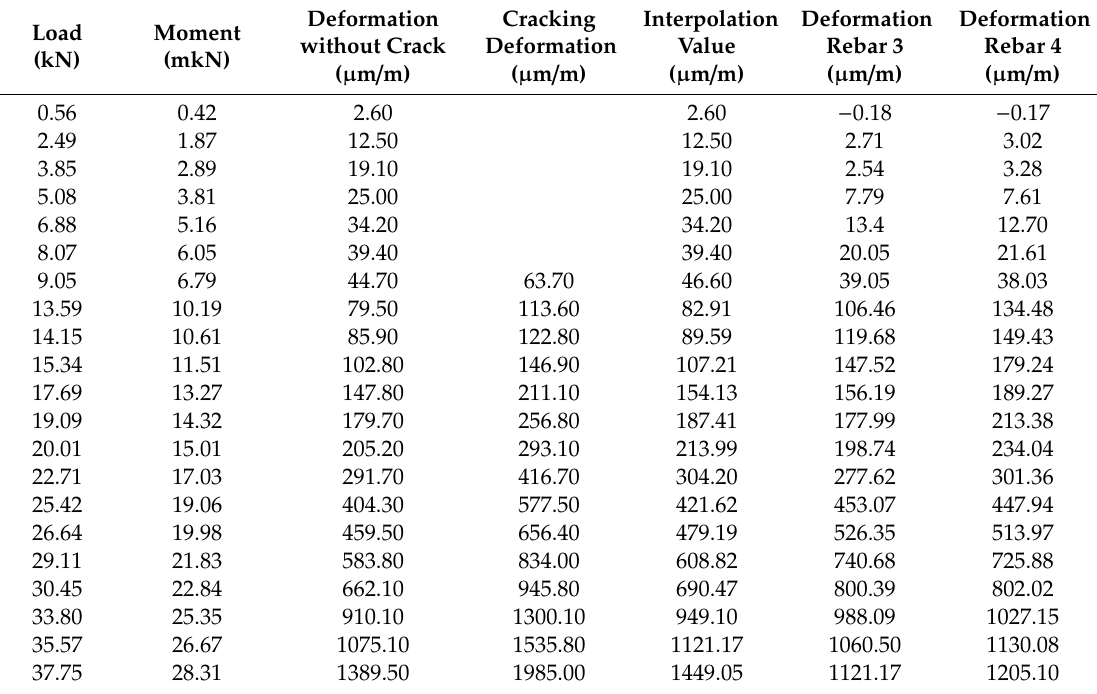
Table 5. Deformation of the rebars 3 and 4 for M fis = 8.5 mkN and f ct = 2.13 MPa with